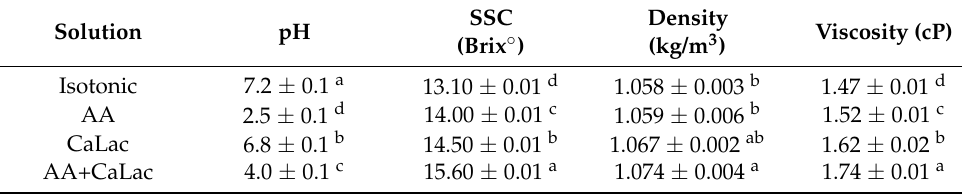
Table 2. Physico-chemical parameters of the solutions used for vacuum impregnation (VI). Solution